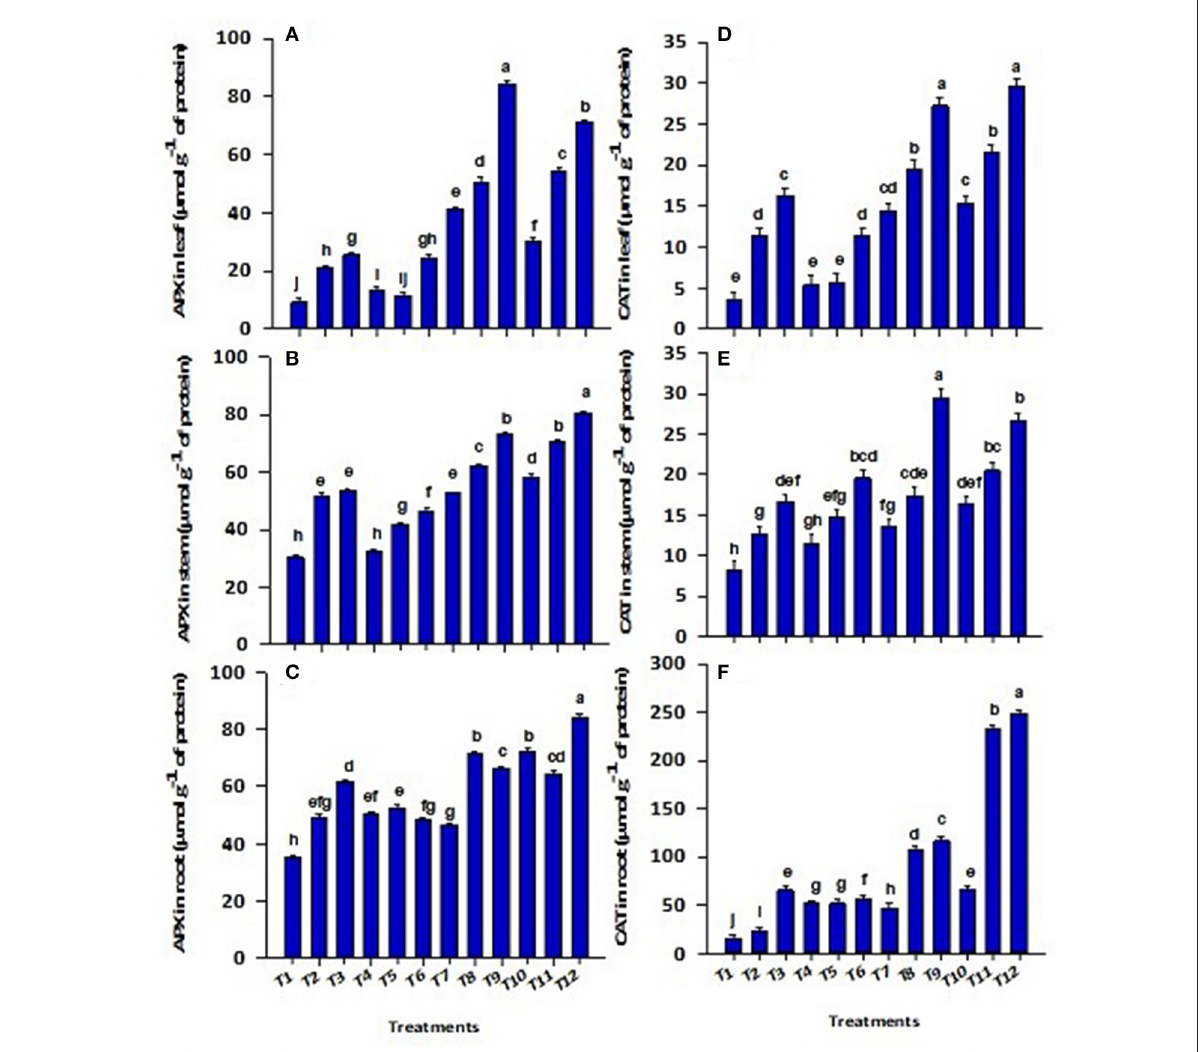
FIGURE3 Concentration of ascorbate peroxidase (APX) in (A) leaf, (B) stem, (C) root and catalase (CAT) in (D) leaf, (E) stem and (F) root of Solanum melongena L. plant grown in heavy metal contaminated soil (waste water applied as stress) under different treatments such as T1 = Control; T2 = CP-Silica gel; T3 = ZnBc; T4 = B1; T5 = B2; T6 = B3; T7 = CP-Silica gel + B1; T8 = CP-Silica gel + B2; T9 = CP-Silica gel + B3; T10 = ZnBc + B1; T11 = ZnBc + B2 and T12 = ZnBc + B3. Values are the average of three replicates ± standard error (SE). Mean bars sharing similar